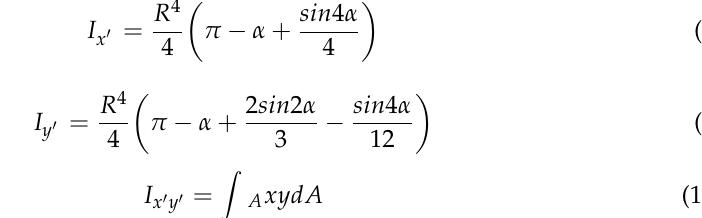
Table 2. Comparison of the region sizes of each crack states.